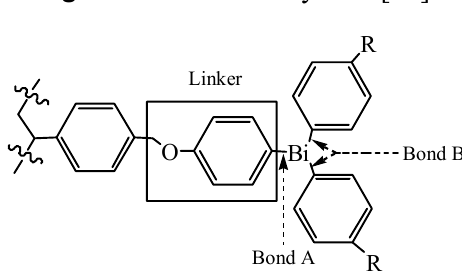
Figure 1. The linker system